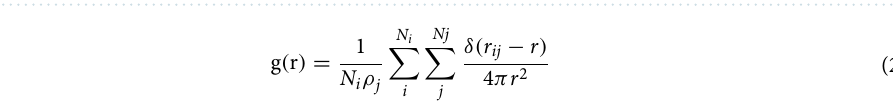
Figure 4. Radial distribution function of the DOX and polymer molcules around the Hexakis surface in the study